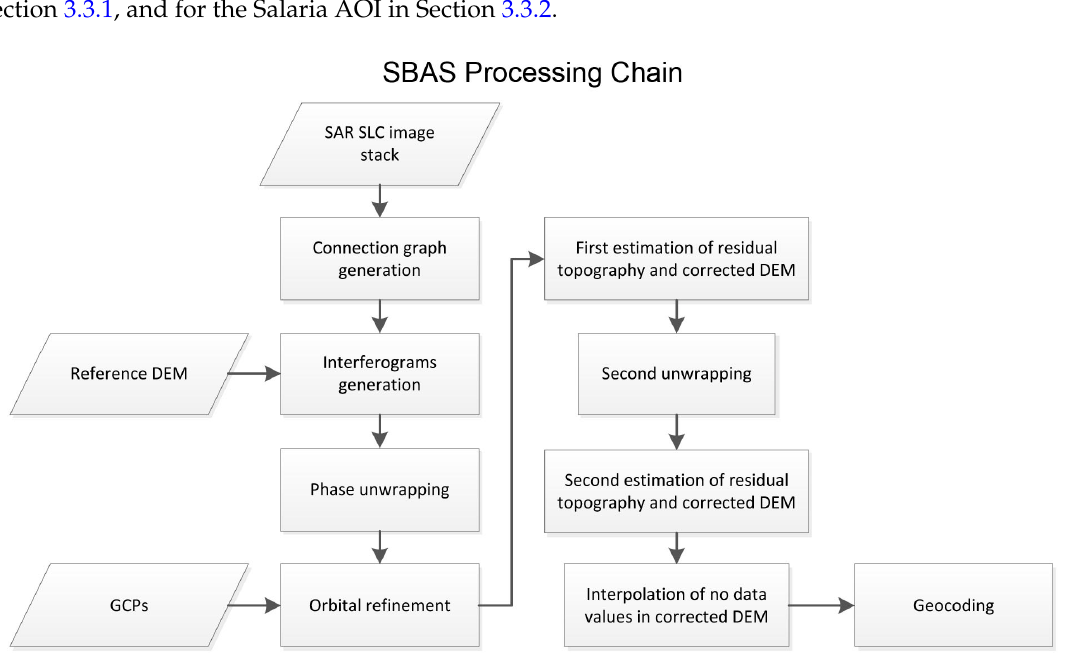
Figure 6. Flow chart showing the Small Baseline Subsets (SBAS) processing chain. This was implemented for both the CSK Stripmap and Spotlight time series using the SARscape software (version 5.2).